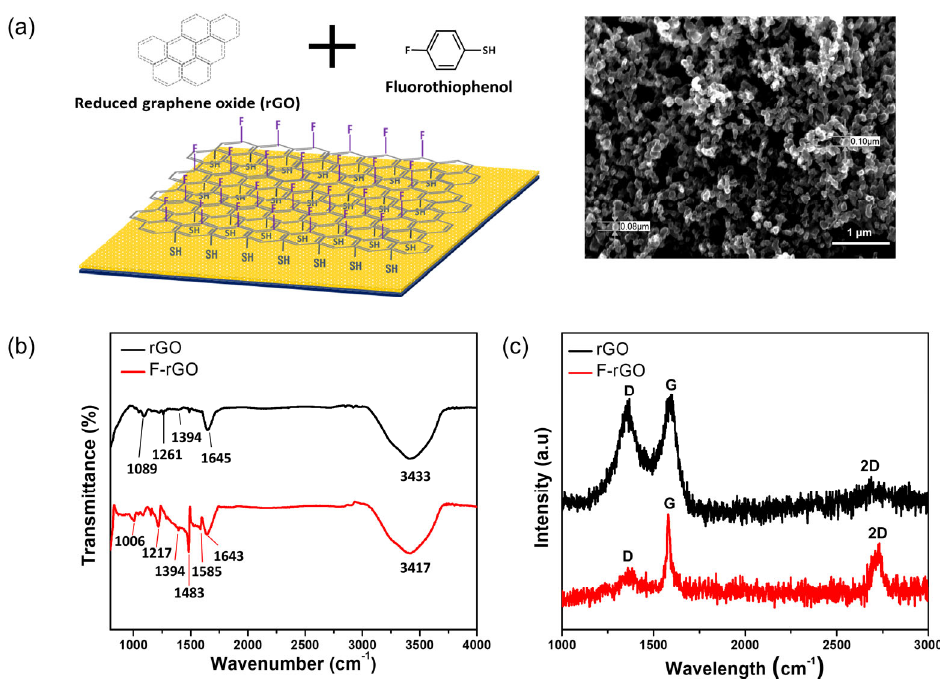
Figure 1. ( a ) Schematic diagram of fluorinated F − rGO and FE ‐ SEM image of the F − rGO on the RE surface. ( b ) FT − IR and ( c ) Raman spectra of the rGO and F − rGO.